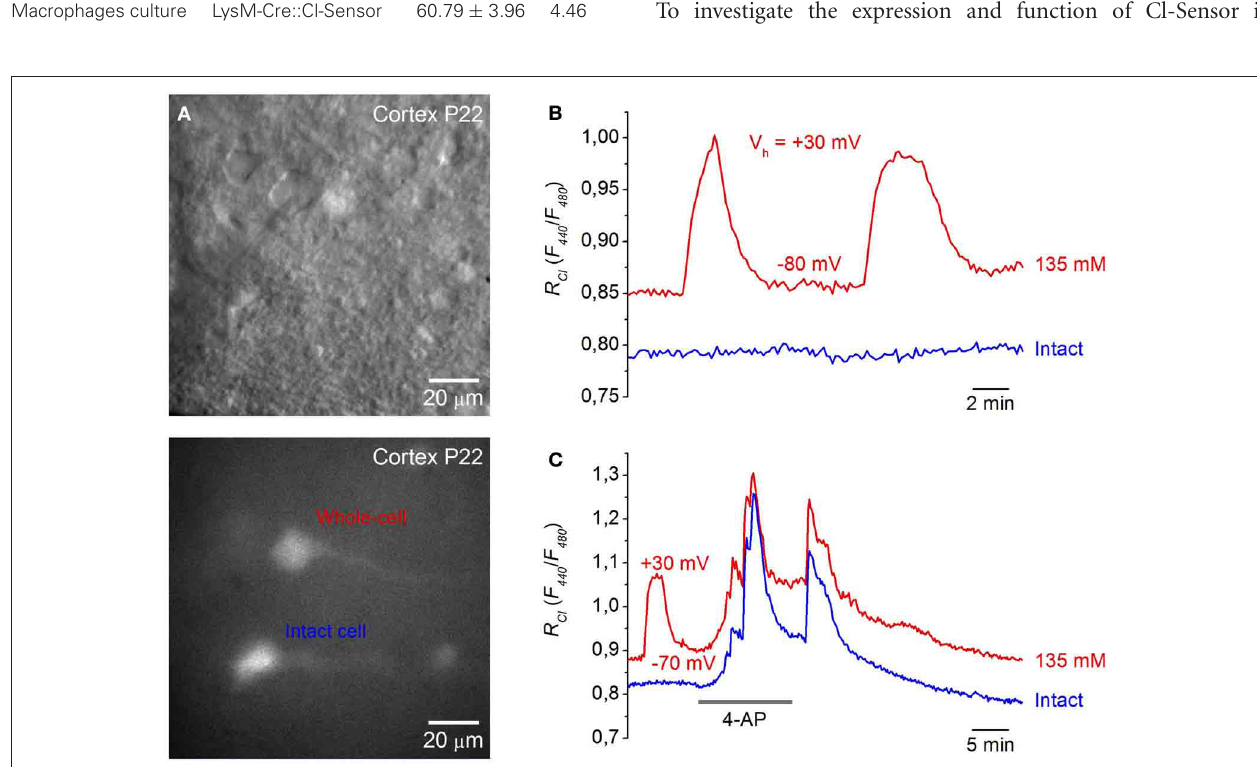
FIGURE 5 | Monitoring [Cl] i in neurons from cortical brain slices. (A) Images of cells in a cortical slice from a P22 mouse expressing Cl-Sensor in visible light (top) and excitation 480nm (bottom). (B) Example of changes in R Cl ( F 440 / F 480 ) after membrane depolarization from a holding potential of − 80 to + 30mV in the neuron from a cortical slice (P15) recorded with pipette solution containing 135mM Cl ( red trace— whole-cell, blue trace— intact cell). Note that depolarization of the cell recorded with high Cl caused an additional